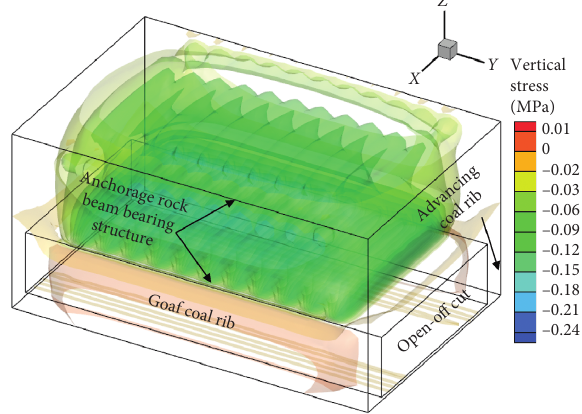
Figure 6: Three-dimensional distribution of the ARBBS in open- off cut